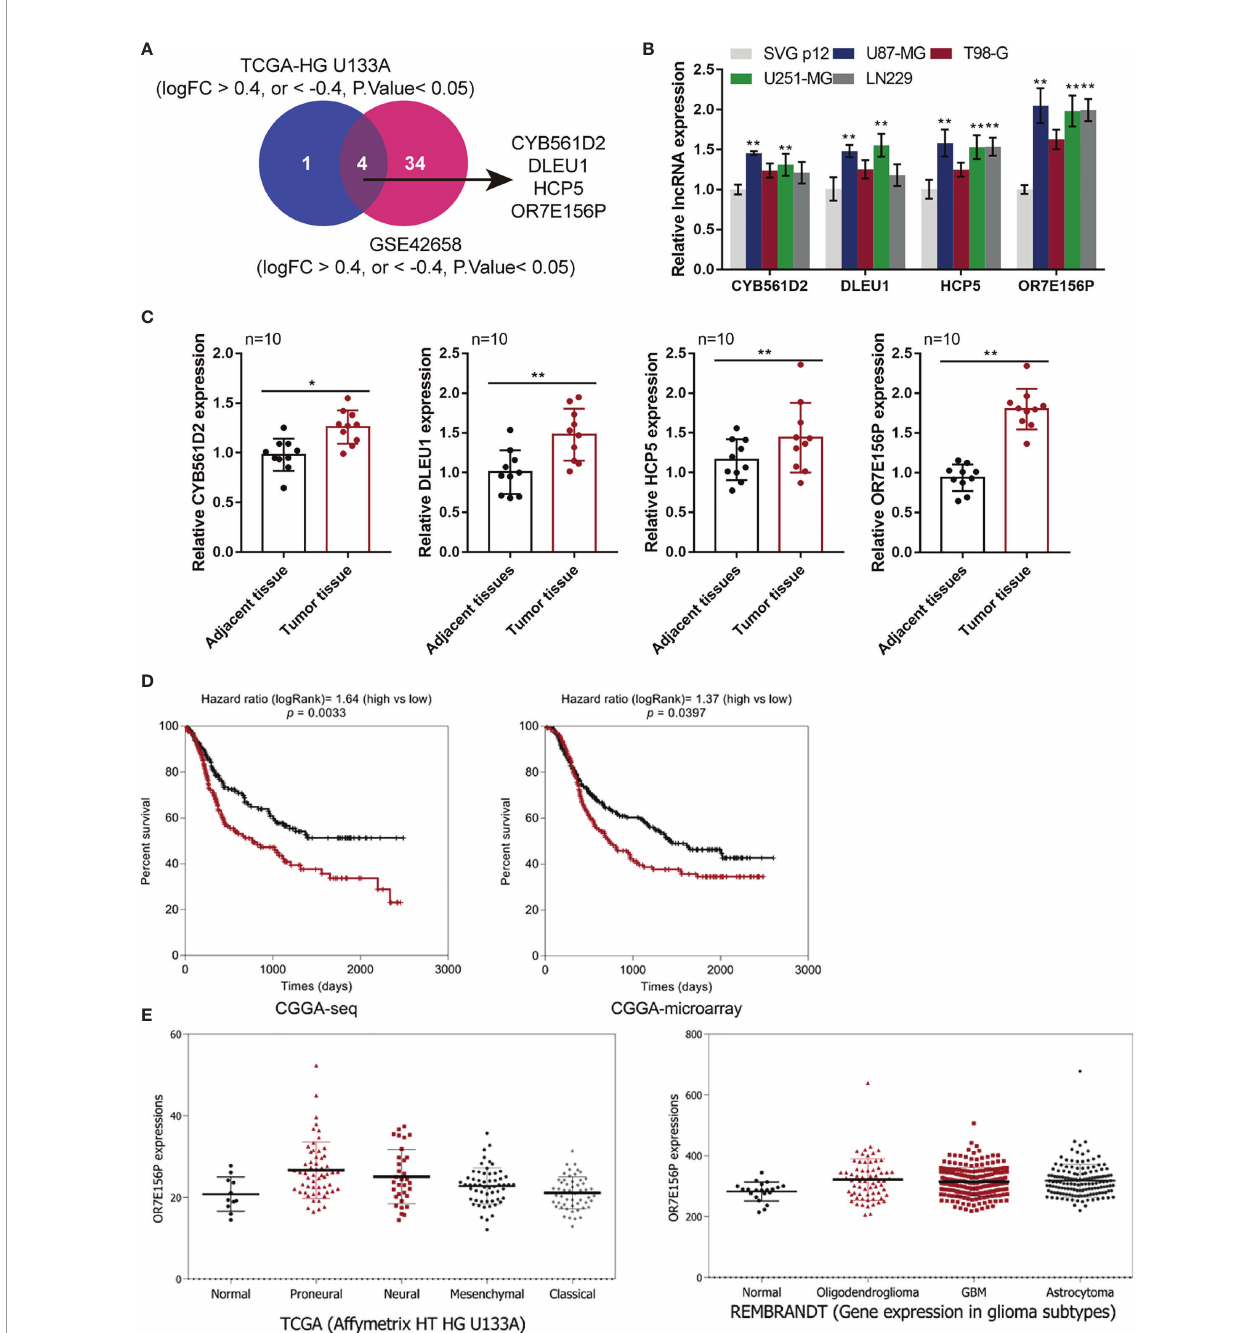
FIGURE 1 | Selection of lncRNAs related to glioma carcinogenesis (A) TCGA-GBM microarray dataset, AffyU133a, from Xena (http://xena.ucsc.edu/) and GSE42658 were used to select lncRNAs related glioma carcinogenesis. TCGA-HG U133UA reported differentially-expressed genes between U251-MGU251- MGglioma tissues and normal non-cancerous tissues (|logFC| > 0.4, P < 0.05); GSE53014 reported differentially-expressed genes in 5 cases glioma tissues and 8 cases normal non-cancerous tissues (|logFC| > 0.4, P < 0.05). After cross-check, CYB561D2, DLEU1, HCP5, and OR7E156P exhibited similar expression trend. (B) The expression of CYB561D2, DLEU1, HCP5, and OR7E156P was determined in SVG p12, U87-MG, T98-G, U251-MG, and LN229 cells by qRT-PCR. (C) The expression of CYB561D2, DLEU1, HCP5, and OR7E156P was determined in 10 paired tumor and adjacent non-cancerous tissue samples by qRT-PCR. (D) Cases from the Chinese Glioma Genome Atlas (CGGA)-seq or CGGA-microarray were divided into two groups, respectively, using the median value of OR7E156P expression as cut-off. The correlation between OR7E156P expression and the survival in patients with gliomas was analyzed using a Cox proportional hazard regression model and log-rank analysis and the results were shown as Kaplan-Meier survival curves. (E) OR7E156P expression in different tissues or different glioma subtypes based on the RNA-seq data from the Human Cancer Atlas database (The Cancer Genome Atlas, TCGA) and the REMBRANDT database (http:// betastasis.com/glioma/rembrandt/). *p < 0.05, **p <